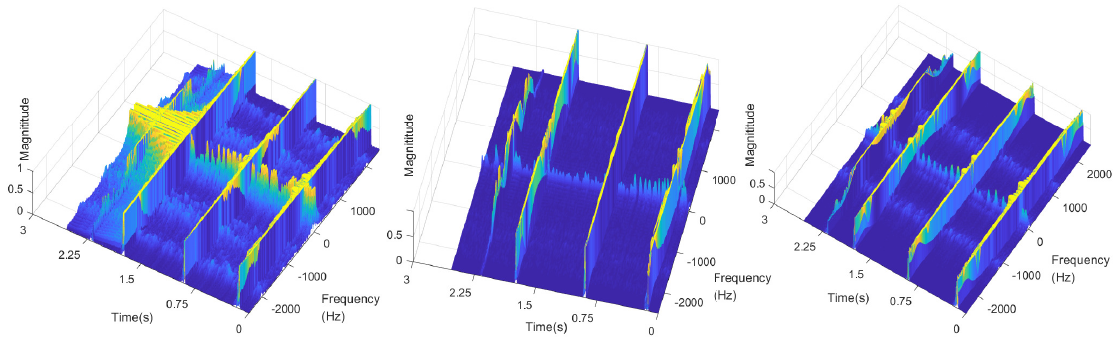
Figure 4. Low magnitude segment of vibration modes in